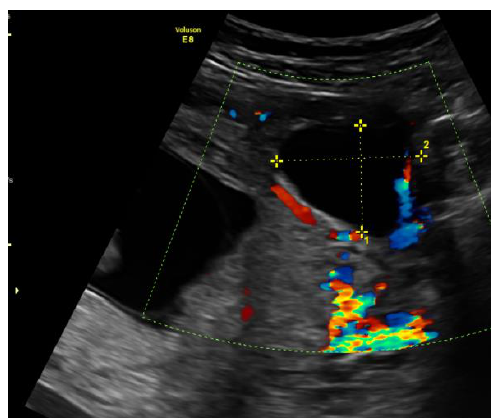
Figure 1. Left cornu of the uterus visualized by transabdominal ultrasonography on the 13w + 3d. An urgent Magnetic Resonance Imaging (MRI) was performed. A 36 × 20 × 36